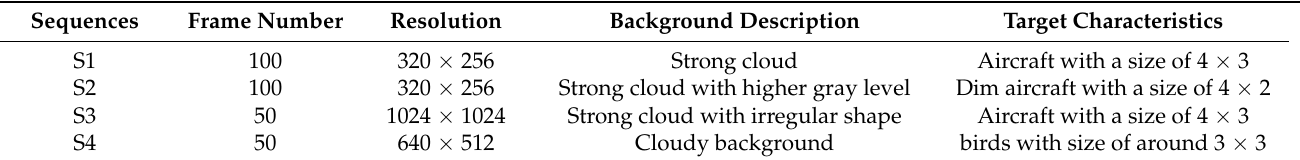
Table 1. The details of the test sequences.